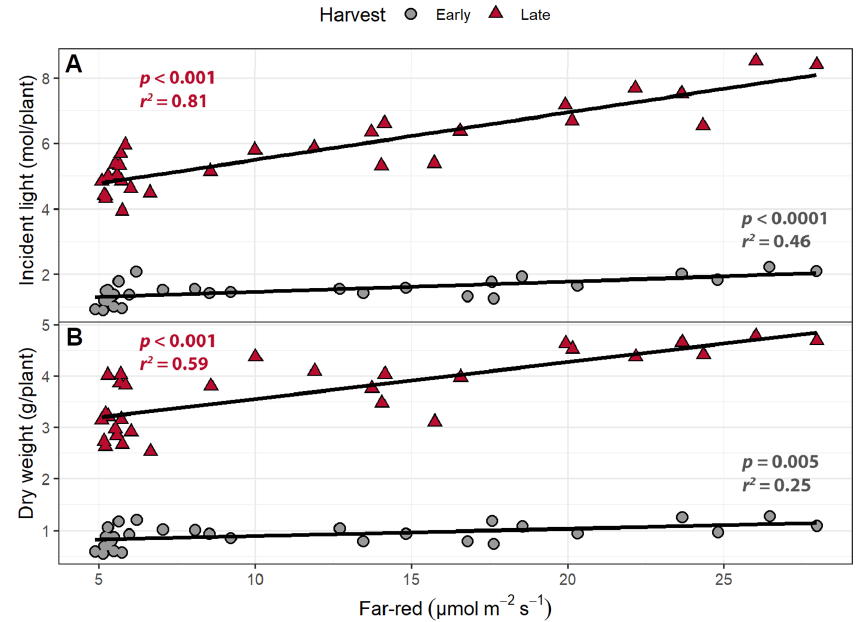
Figure 4. ( A ) The correlation between supplemental far-red light intensity and cumulative incident light (400–800 nm) and ( B ) dry weight. “Green Salad Bowl” lettuce ( Lactuca sativa ) plants were grown under a photosynthetic photon flux density of 207 ± 13 µmol m − 2 s − 1 supplemented with varying intensities of far-red. The early harvest occurred 16 days after germination, while the late harvest occurred 25 days after germination. Plants 2021 , 10 , x FOR PEER REVIEW